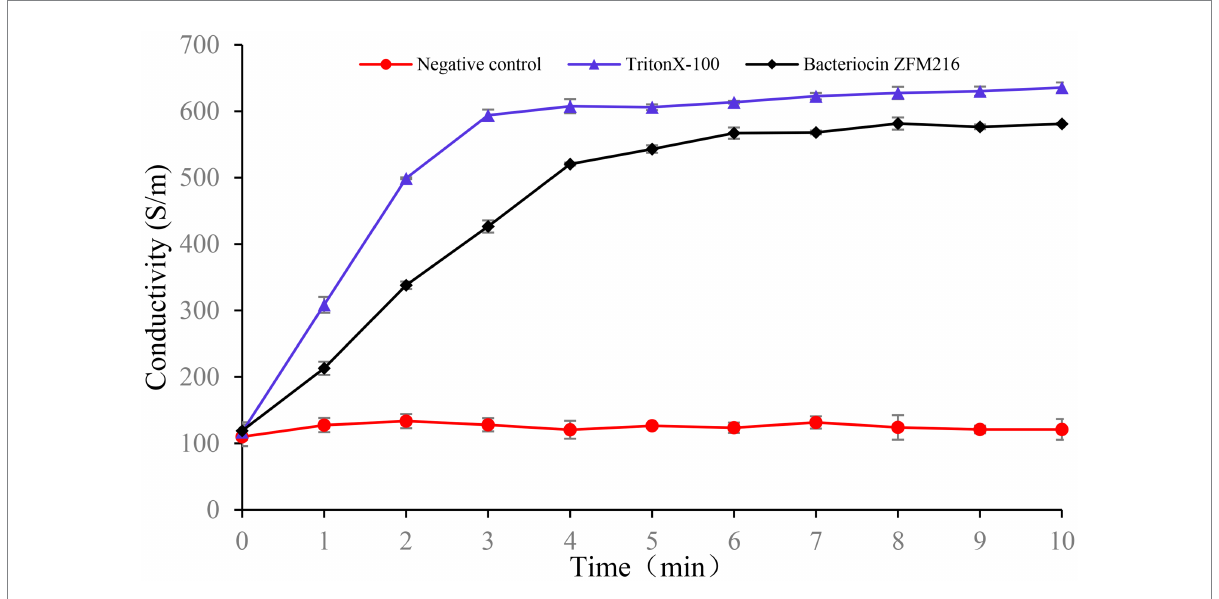
FIGURE 7 The effect of bacteriocin ZFM216 on the conductivity of indicator